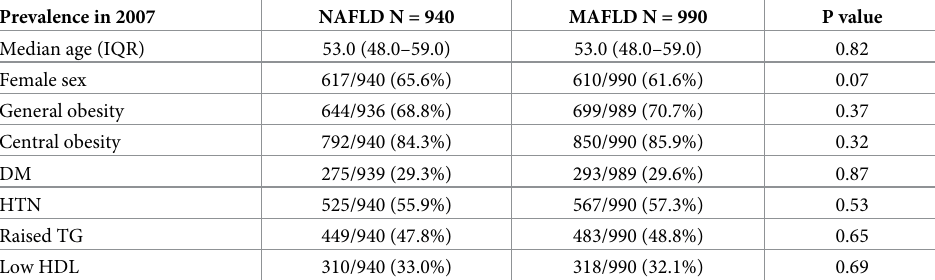
Table 1. Characteristics NAFLD and MAFLD from the original cohort